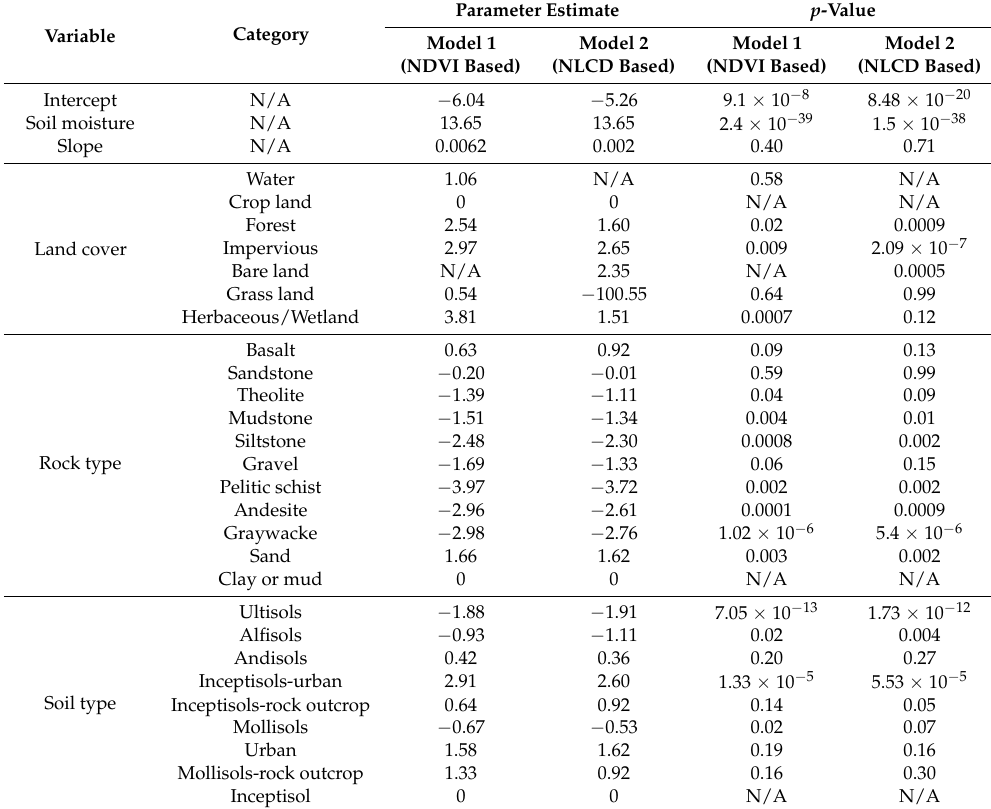
Table 9. Parameter estimates and p -values of developed logistic regression